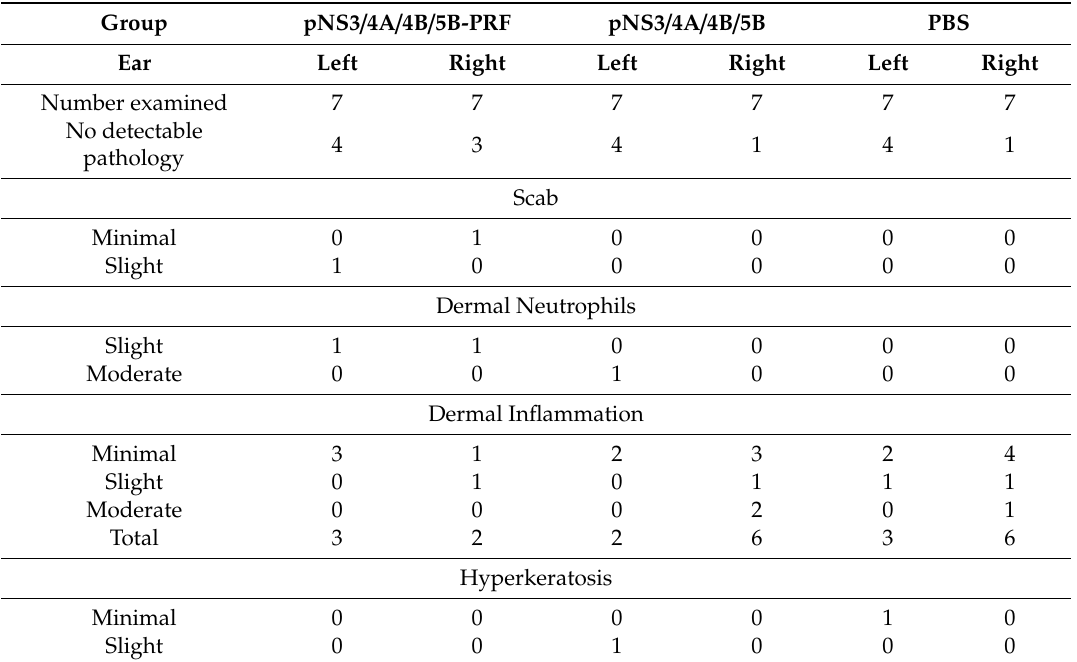
Table 1. Histopathological incidence at the site of injection in vaccinated C57 / BL6